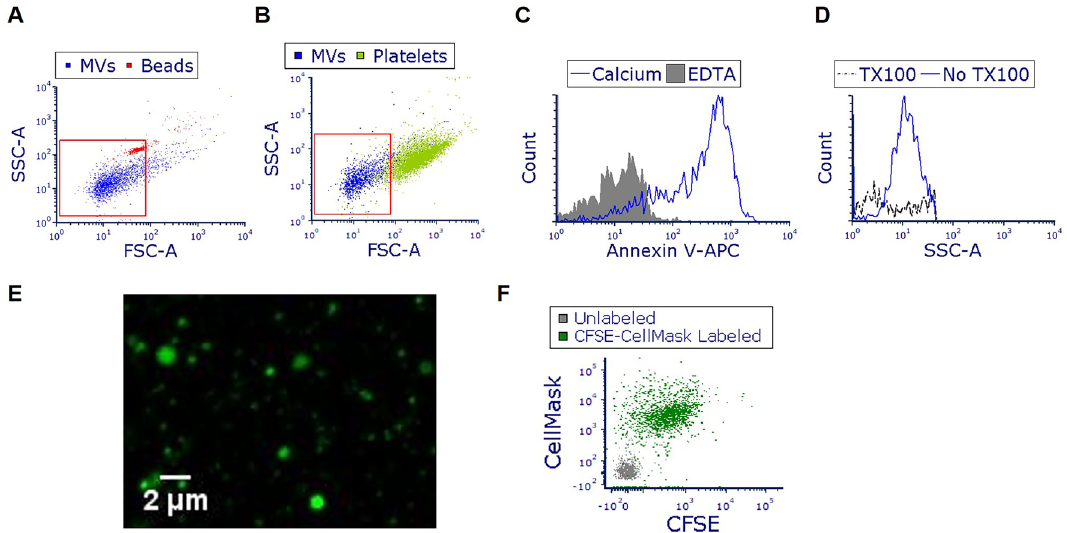
Figure 1. Characterization of microvesicles (MVs) produced from pneumolysin (PLY)-treated alveolar epithelial cells. A549 cells were treated with PLY (100 ng/ml). After 4 h, conditioned media was collected and MVs were isolated and characterized. ( A,B ) Representative FACS analysis (overlay dot blots) of isolated vesicles (blue dots), and of ( A ) 1 μm beads (red dots) or ( B ) human platelets (green dots). ( C ) MVs were stained with annexin V-APC in the presence or absence of calcium and analyzed by FACS. ( D ) MVs were treated with Triton-X 100 and analyzed by FACS. ( E ) CFSE-labeled MVs (green) were visualized using confocal microscopy. ( F ) MVs were labeled with CFSE (FITC) and CellMask (APC) and analyzed by FACS. In the representative dot blot, MVs labeled with CFSE and CellMask are shown in green. Grey dots represent unstained vesicles (background